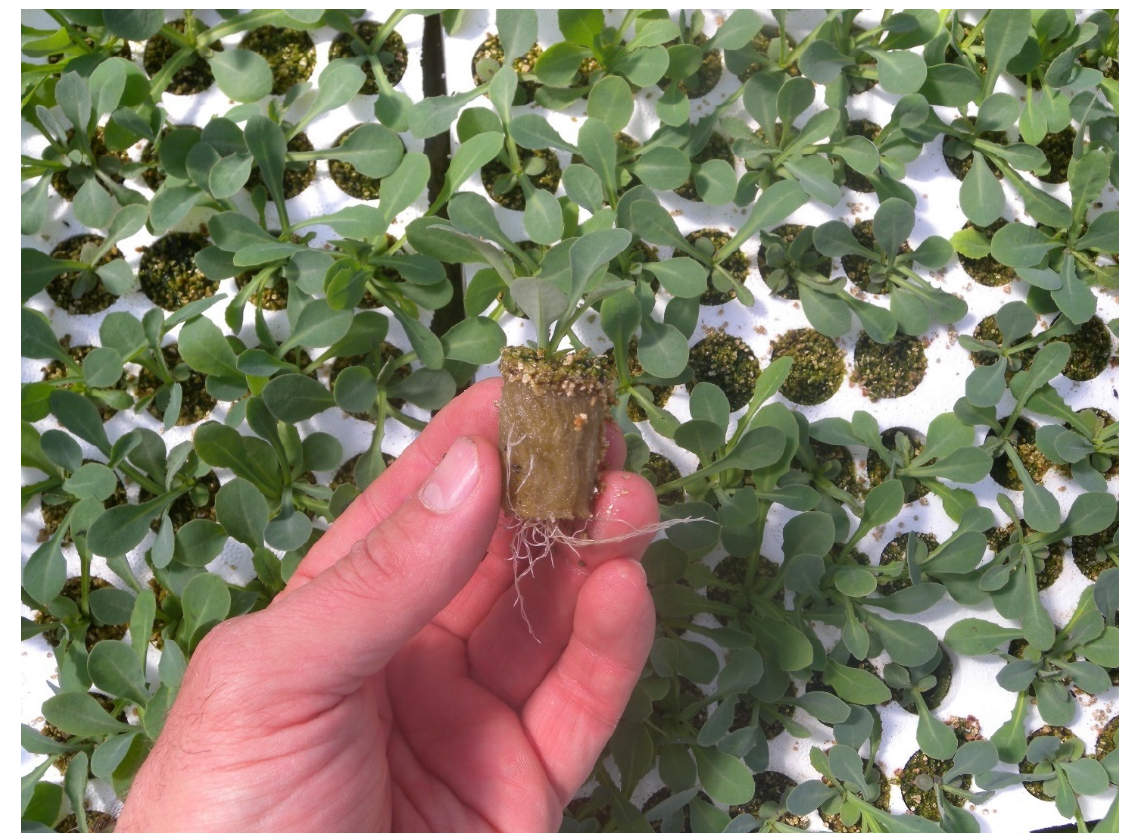
Figure 1. Seedlings of Reichardia picroides after 10 weeks from sowing, ready for transplanting into floating system.